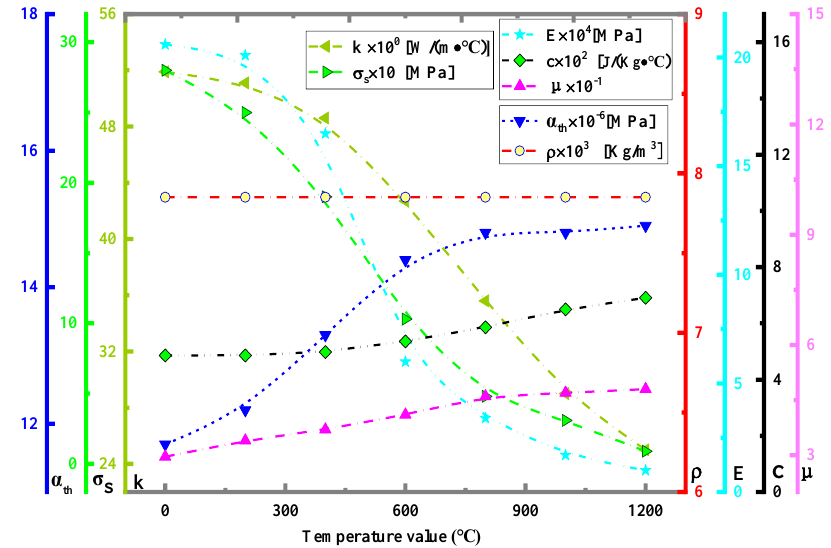
Figure 3. Schematic diagram of meshing, functional relationship between force and displacement. ( a ) Schematic diagram of the grid division, ( b ) schematic diagram of the action of the baffle, ( c ) equation of the relationship between force and x-directional displacement and ( d ) specific values of force and x-directional displacement.